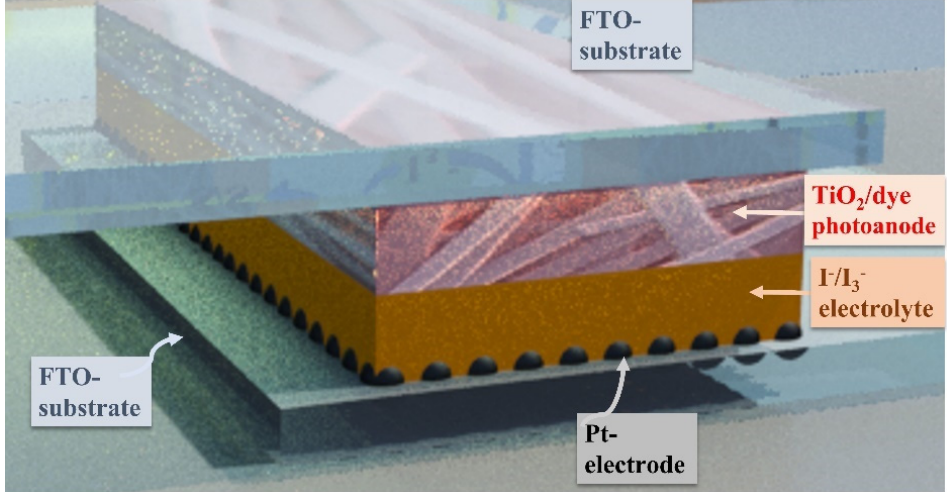
Figure 1. Schematic diagram of the fabricated solar cell based on the synthesized